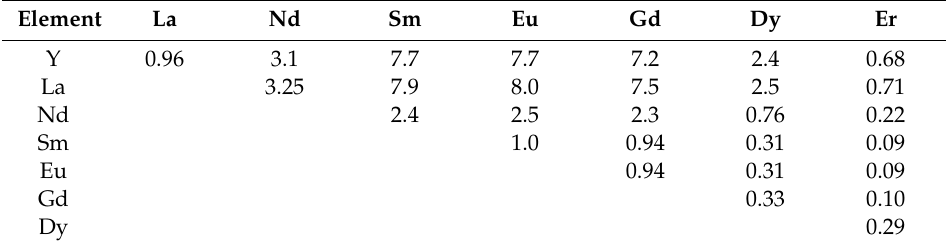
Table 5. Calculated logarithmic distribution coe ffi cients (precipitation of the element in the horizontal row for every one of the elements in the vertical column).